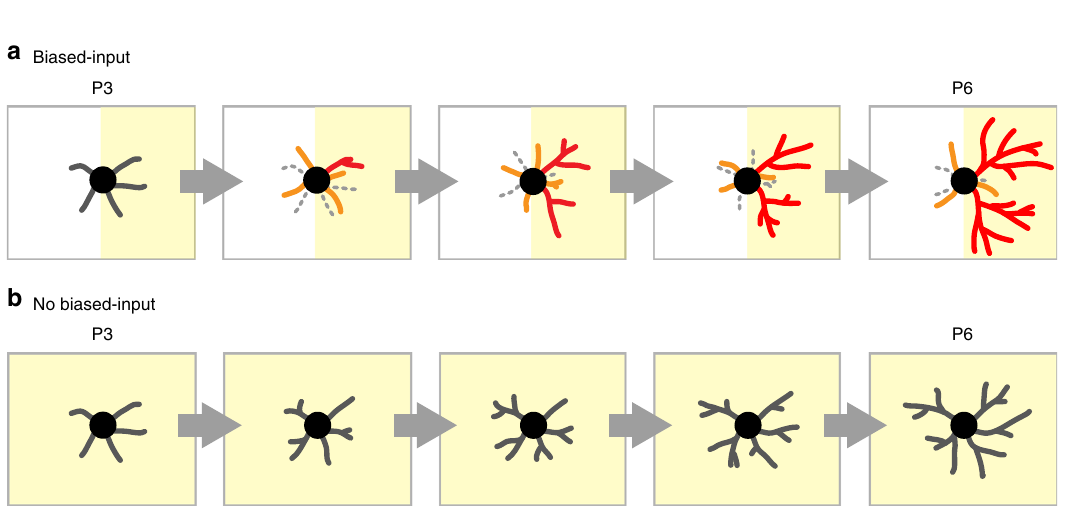
Fig. 7 Differential BD tree dynamics in neonatal barrel cortex SS neurons. a In the normal neonatal mouse barrel cortex, eSS neurons receive spatially biased TCA inputs, predominantly from the barrel-center side (yellow); while on the other side (white), they receive no inputs or inputs from inappropriate TCAs. At P3, eSS neurons already have BD orientation bias, albeit weak, toward the barrel-center side (Fig. 2g). However, at this age, individual BD trees are still primitive (Figs. 2f, 3d and Supplementary Fig. 3b) and the BD orientation bias is ascribed primarily to the larger number of BD trees on the barrel side vs. the other side (Fig. 3c). BD orientation bias increases drastically between P3 and P6 (Fig. 3b), while the ratio of inner tree number to total tree number does not change (Supplementary Fig. 3a). BD trees are highly dynamic and emerge (orange) and disappear (dashed gray BDs) frequently both inside and outside the barrel center-side half (Fig. 4a – e). Meanwhile, only a fraction of trees (mostly inner) are stabilized (Fig. 4d – f) and these become